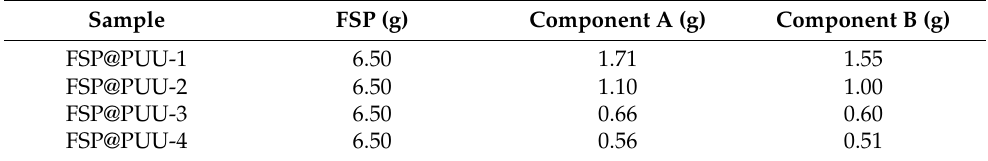
Figure 3. Schematic diagram of the preparation of FSP@PUU. Table 2. The raw material formulations for the preparation of FSP@PUU. Sample